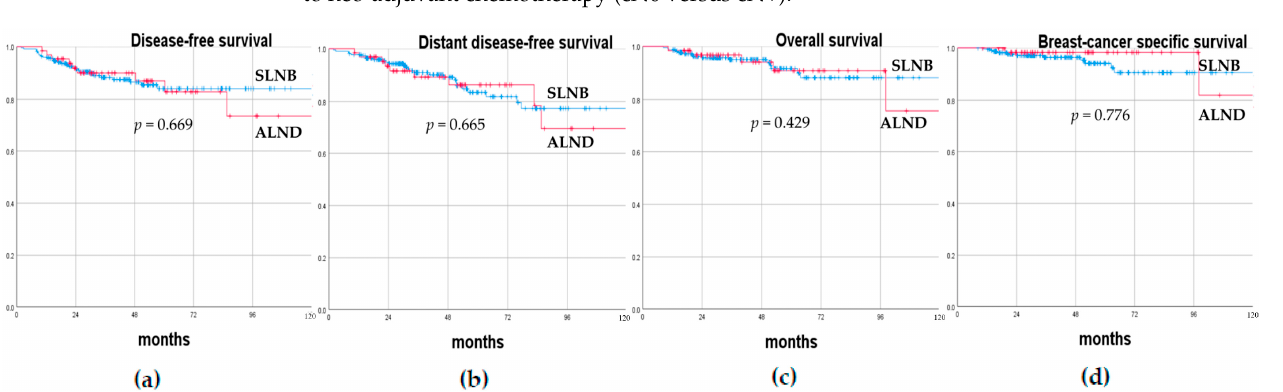
Figure 1. ( a ) Disease-free survival, ( b ) distant disease-free survival, ( c ) overall survival, ( d ) and breast-cancer-specific survival curves of breast cancer patients according to their axillary status prior to neo-adjuvant chemotherapy (cN0 versus cN+).